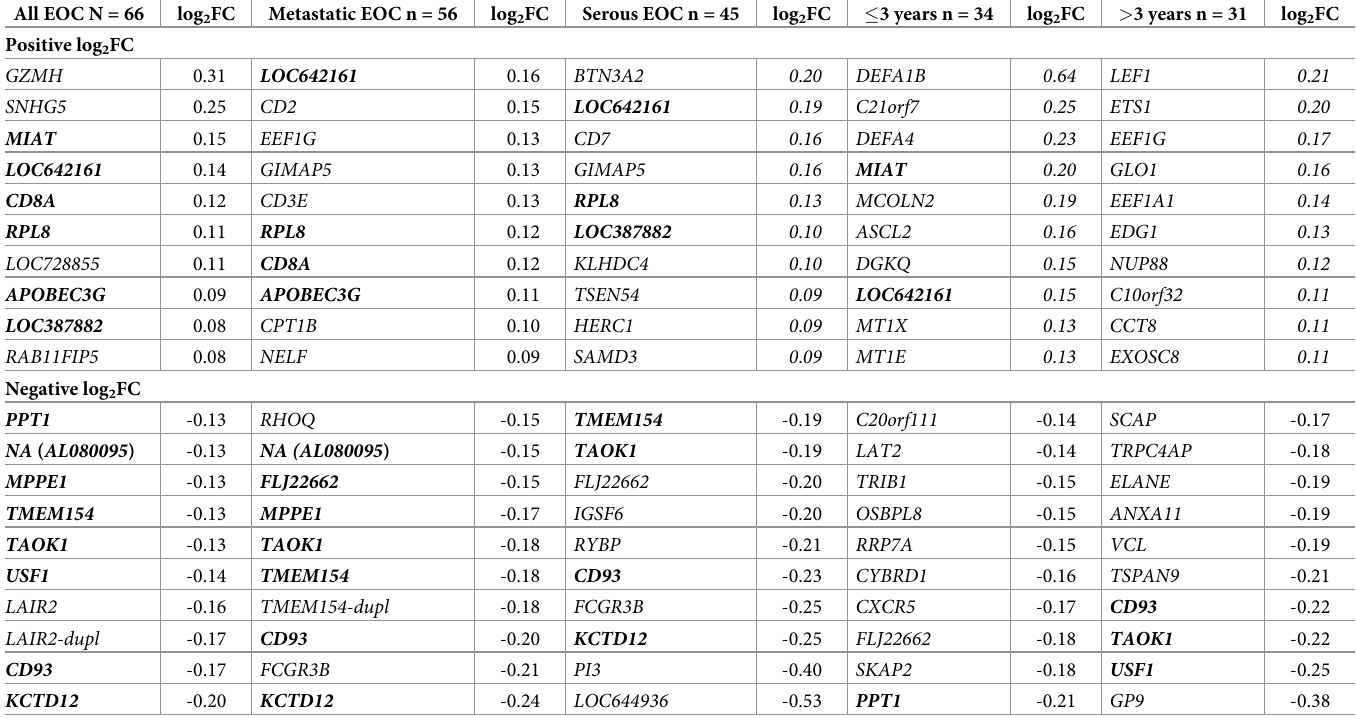
Table 3. Probes with the 20 greatest absolute log 2 FC values a among the 100 b lowest p-values in single-gene linear models (case-control) of prospective blood sam- ples from all cases of epithelial ovarian cancer (EOC) and subgroup analyses by clinicopathologic characteristics and interval to